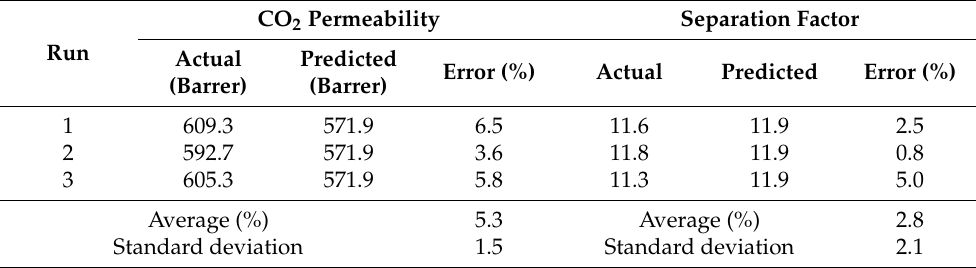
Table 7. Validation of optimal condition for membrane separation.